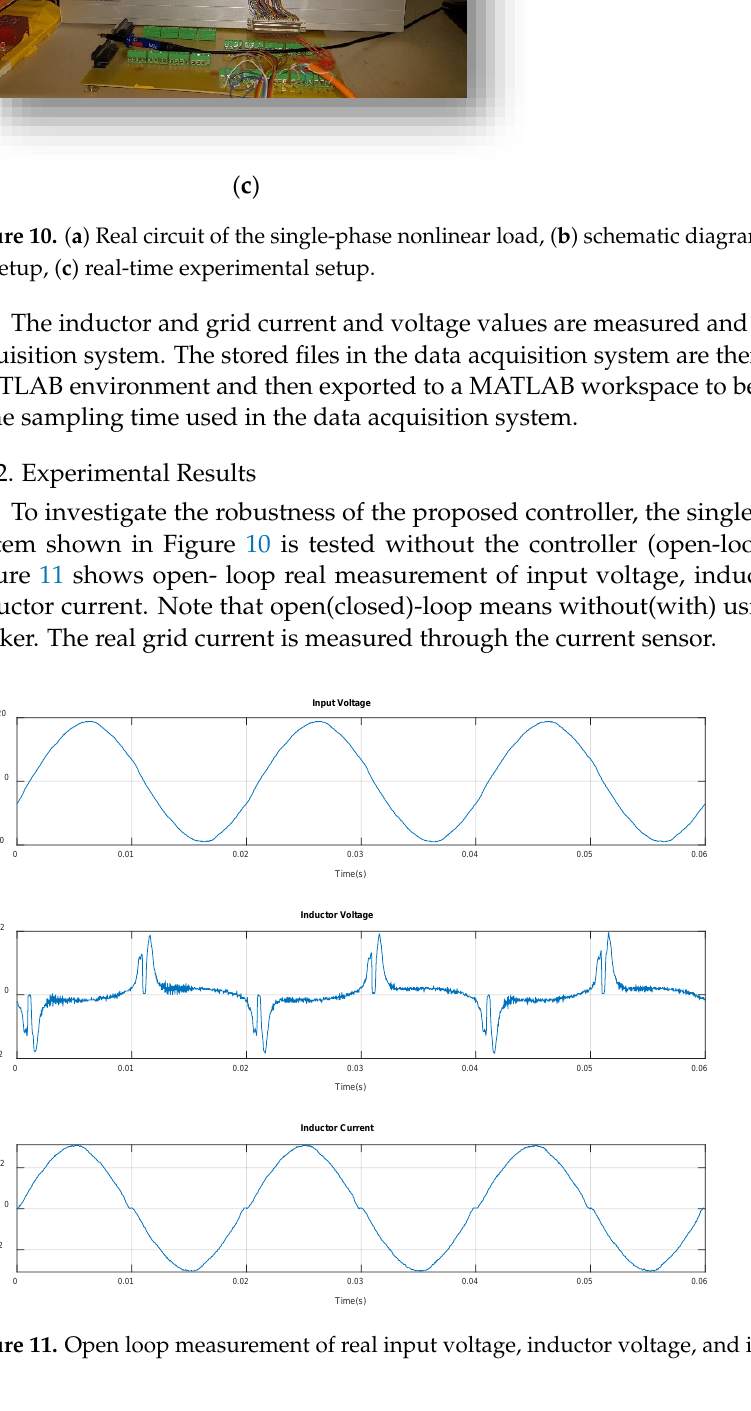
Figure 11. Open loop measurement of real input voltage, inductor voltage, and inductor current.